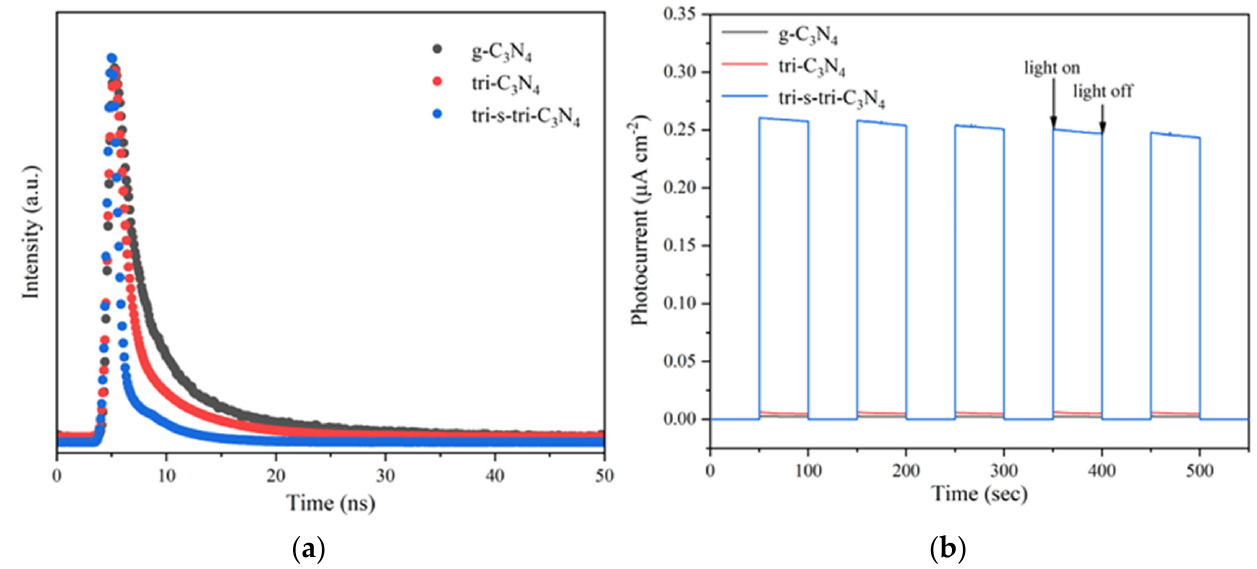
Figure 6. TR-PL spectra ( a ) and transient photocurrent response plots ( b ) of g-C 3 N 4 , tri-C 3 N 4 , and tri-s-tri-C 3 N 4 .